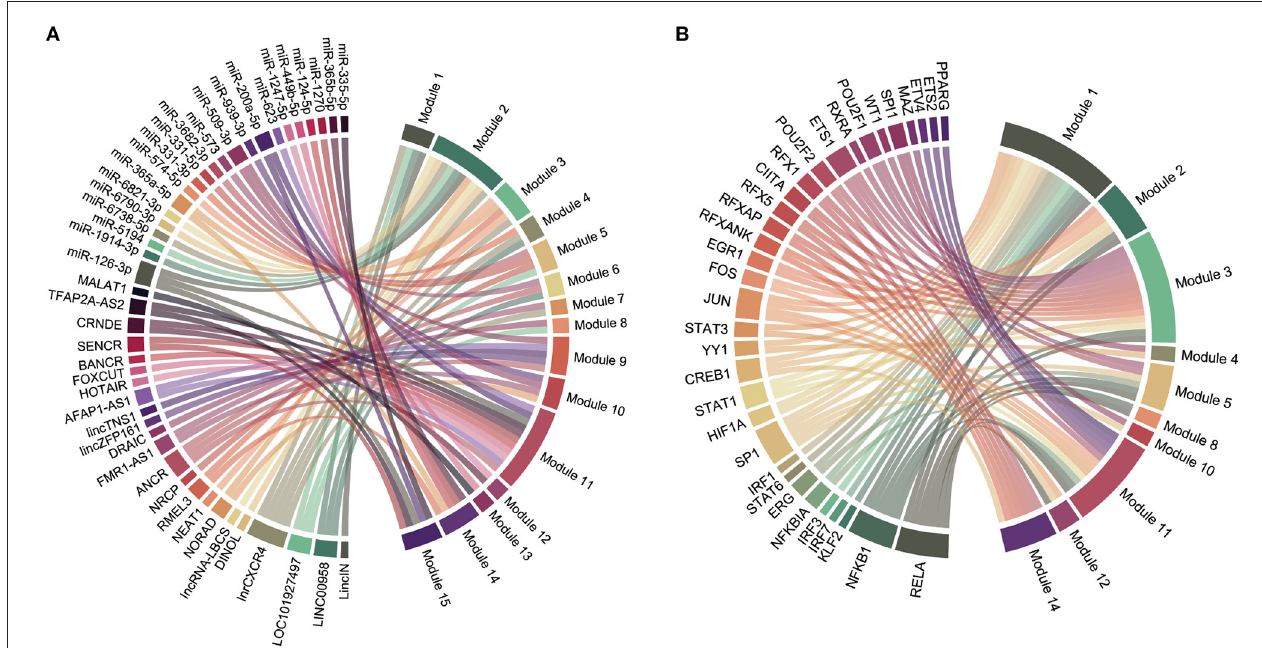
FIGURE 6 | Regulatory chord diagram of key ncRNAs/TFs and functional modules. (A) Regulatory relationship between ncRNAs and functional modules. (B) Regulatory relationship between TFs and functional